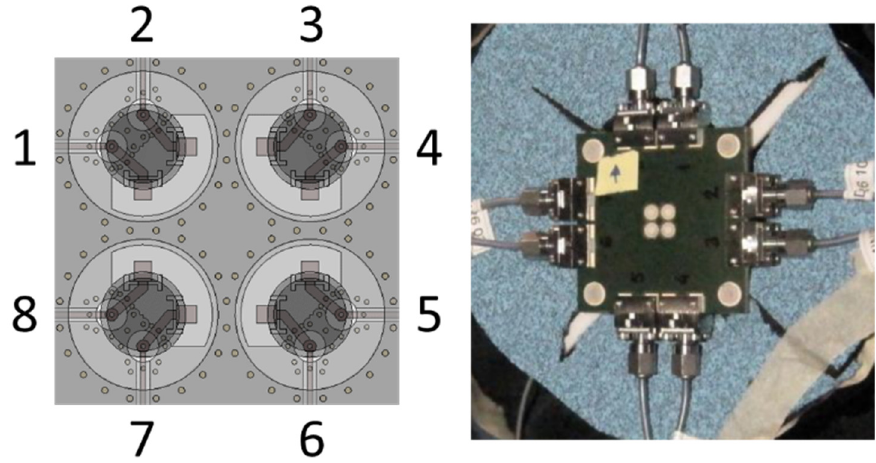
Figure 8. 2 × 2 antenna array configuration ( left ); the manufactured prototype ( right ).